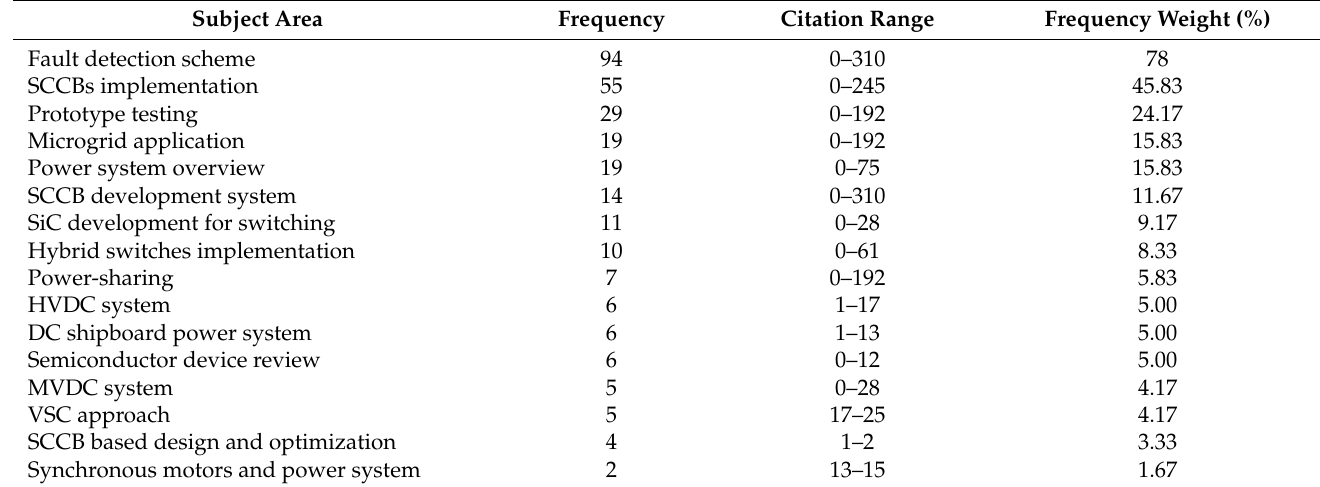
Table 5. Distribution of Papers in Different Subject